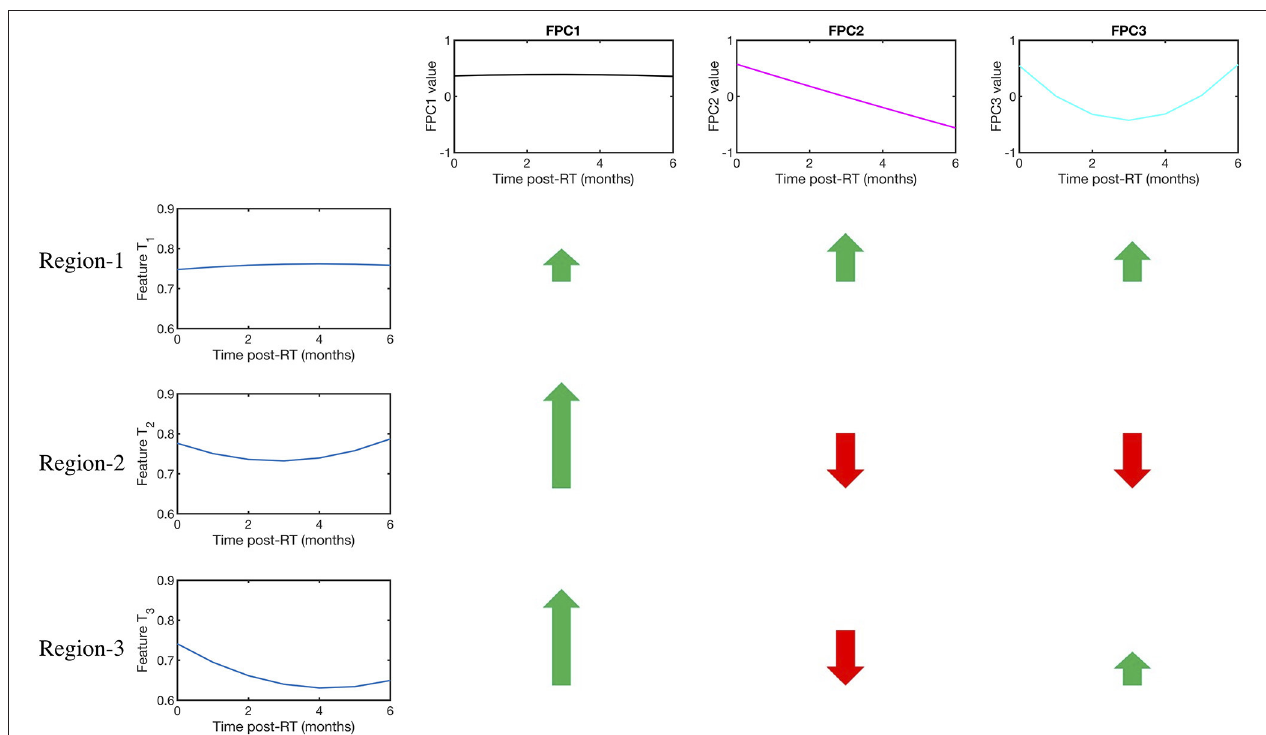
FIGURE 3 | Visual explanation of the FPCA algorithm and its advantages. The first row displays the 3 functional principal components (FPCs). On the left column, the temporal evolution of a Gray Level Co-occurrence Matrix (GLCM)-3D feature is shown for three mandibular regions namely Regions 1,2, and 3. Regions 1 and 2 did not develop ORN, while 3 did. We note that Regions 1,2, and 3 all have similar baseline values, so cannot be distinguished by a model built solely on pre-radiotherapy features. Further, Regions 2 and 3 also have similar change in their values, which a delta radiomics model would see as equivalent scenarios. On the other hand, the difference in the temporal kinetics is efficiently encoded in the 3 FPCs. The color and length of the arrows indicate the sign ( ve or –ve) and magnitude (large or low) of + relative contribution made by each FPC in explaining the time series. So, for example, Region 2 and Region 3, which appear alike to a pre-radiotherapy model and a delta radiomics model, can be readily distinguished because of the difference in relative contribution made by the 3rd